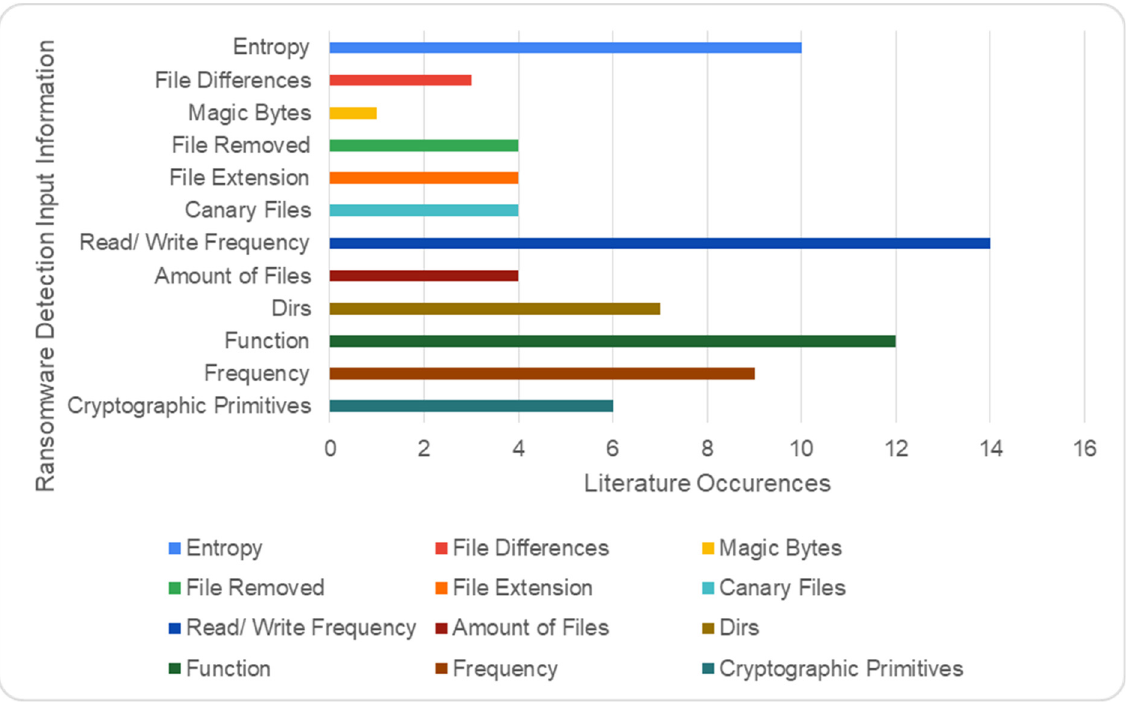
Figure 14. Ransomware detection tools and input information.